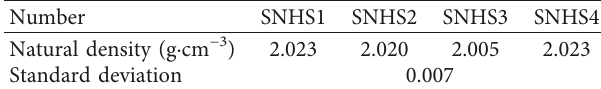
Table 4: Natural density test results.